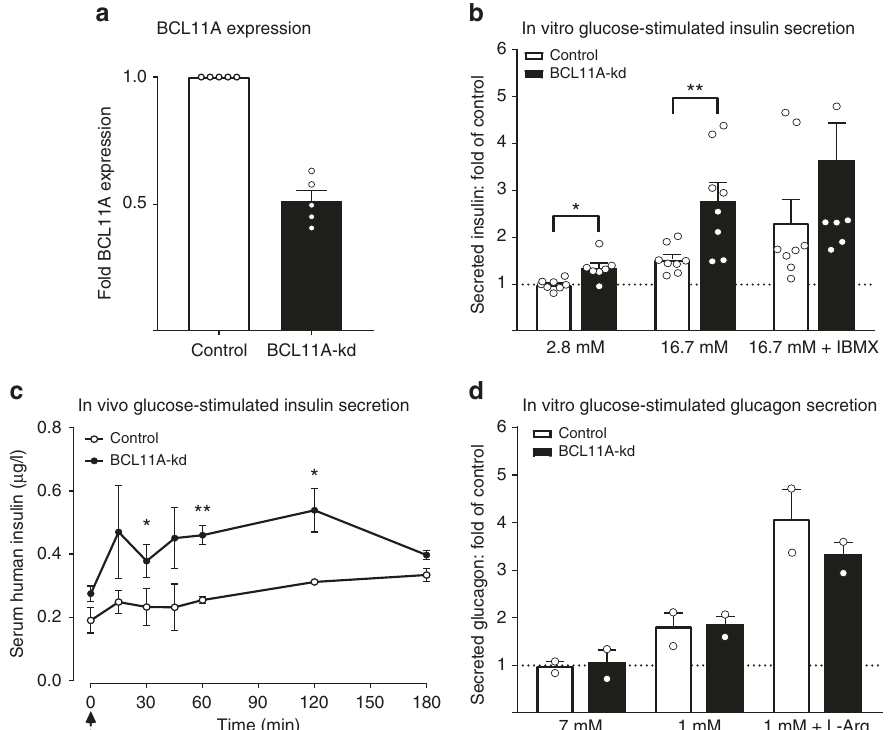
Fig. 5 BCL11A knockdown enhances human insulin secretion. a BCL11A mRNA expression in human pseudo islets following transduction with control (white bar) or BCL11A-kd (black bar) lentiviral vectors ( n = 5). b In vitro glucose-stimulated insulin secretion from human pseudo islets after transduction with control (white bars) or BCL11-kd (black bars) lentiviral vectors. Secreted insulin is normalized to insulin content, ( n = 5, sampled in duplicate). c In vivo glucose-stimulated insulin secretion from human pseudo islets 30 days post-transplantation under the renal capsule of male NSG mice. Pseudo islets were transduced with control (white bars) or BCL11-kd (black bars) lentiviral vectors prior to transplantation. ( n = 3). d In vitro glucose-stimulated glucagon secretion from human pseudo islets after transduction with control (white bars) or BCL11-kd (black bars) lentiviral vectors. Secreted glucagon is normalized to glucagon content, ( n = 2). See also Supplementary Figures 5 & 6. The data presented as mean, error bars represent the standard error, and two-tailed t tests were used to generate p values. * p < 0.05, ** p <